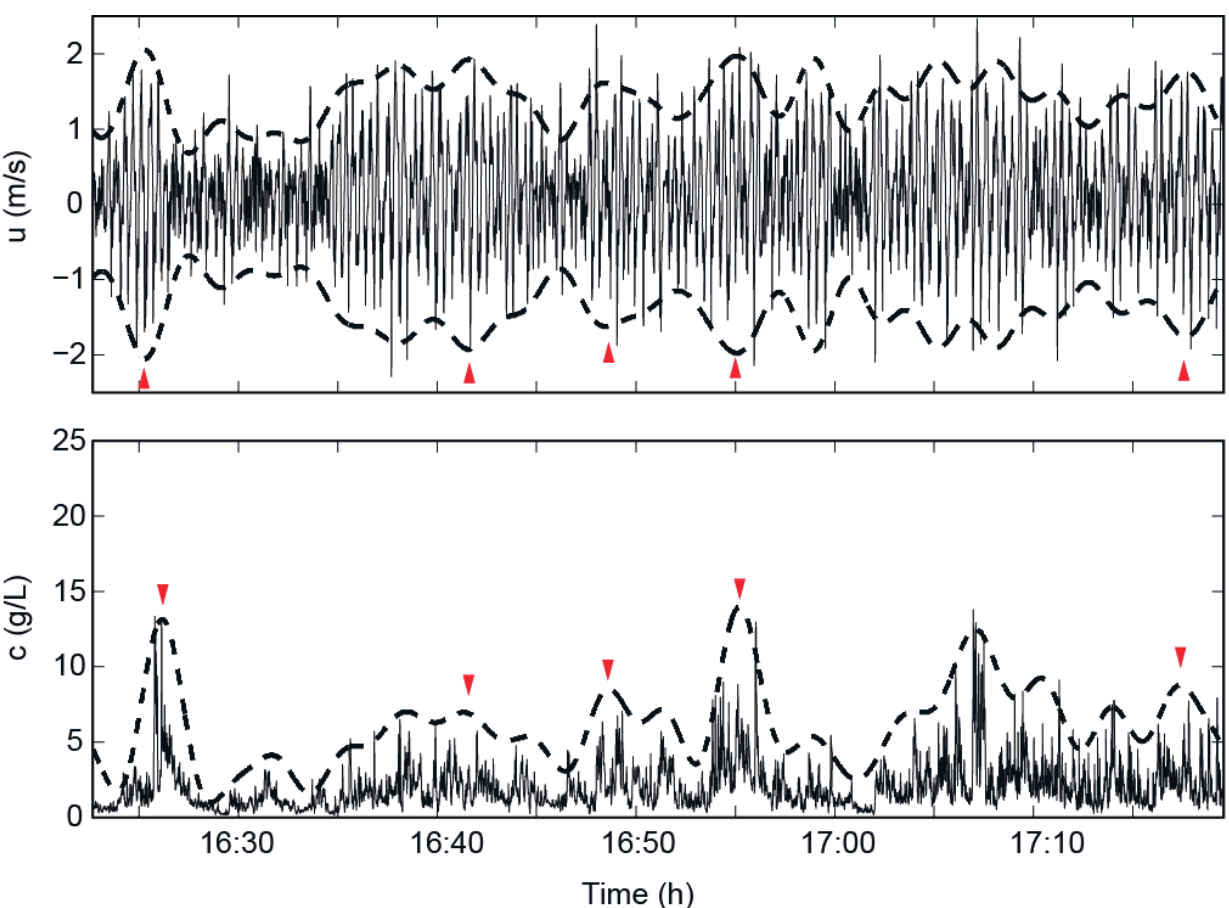
Figure 5. Time series of ( a ) cross-shore current velocity u ( z = 0.25 m; solid line) and the envelope function of u (thick, dashed lines); and ( b ) suspended sediment concentration c ( z = 0.05 m; solid line) and low-pass-filtered c (thick, dashed line) (just outside of the breaker line, over a flat bed, Ambakandawila Beach, Chilaw, Sri